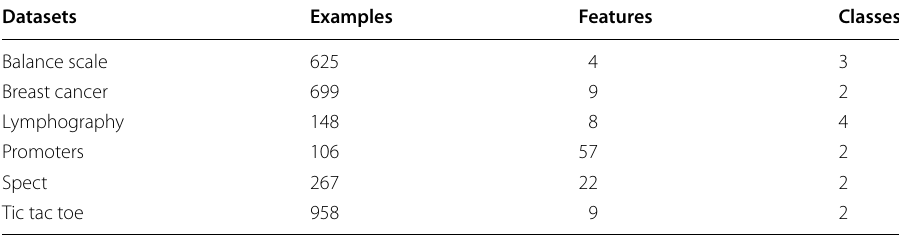
Table 2 Basic information on the categorical datasets